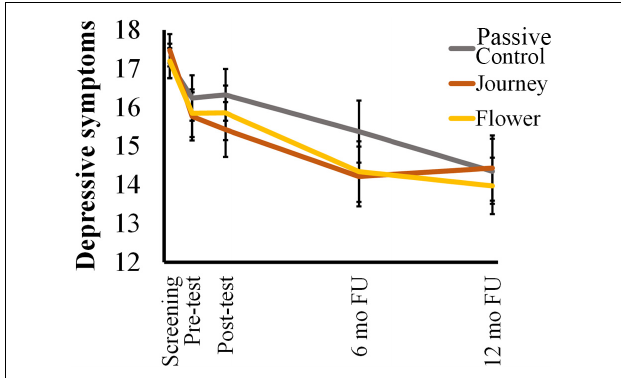
FIGURE 4 | Trajectories of mean depressive symptoms (CDI) scores by condition. Error bars represent standard errors.